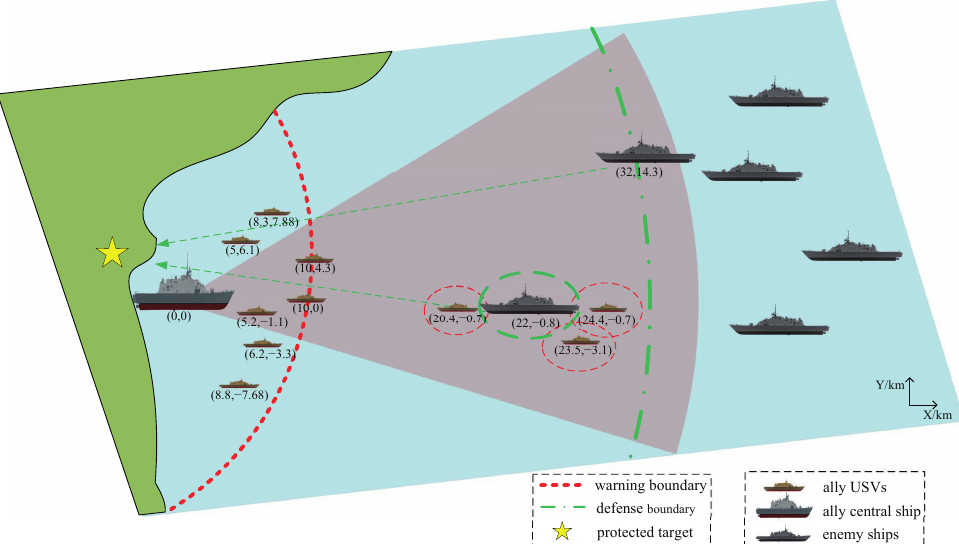
Figure 5. A typical coastal defense scenario with multi-USV cooperation.